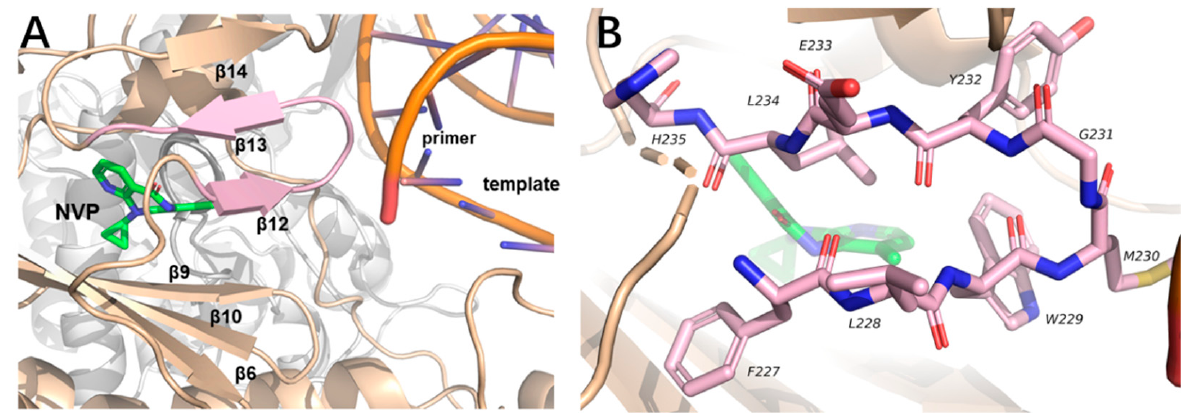
Figure 3. ( A ) NNIBP of HIV-1 RT is shown with nevirapine (green) and primer grip (pink). ( B ) Amino acid composition of primer grip.